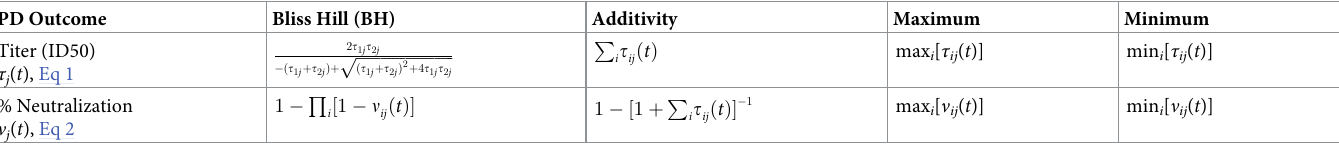
Table 1. Summary of equations for PD interaction models relating bNAb ( i ) to virus ( j ). Formula for Bliss-Hill ID50 illustrated for 2-bNAb combinations only. PD Outcome Bliss Hill (BH) Additivity Maximum